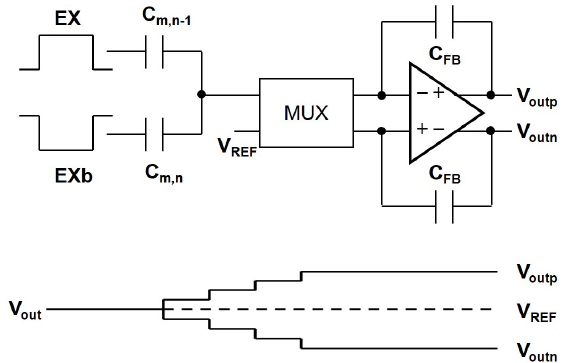
Figure 10. The dynamic range of the output voltage is enhanced by using differential-ended charge amplifier and out-of-phase excitation